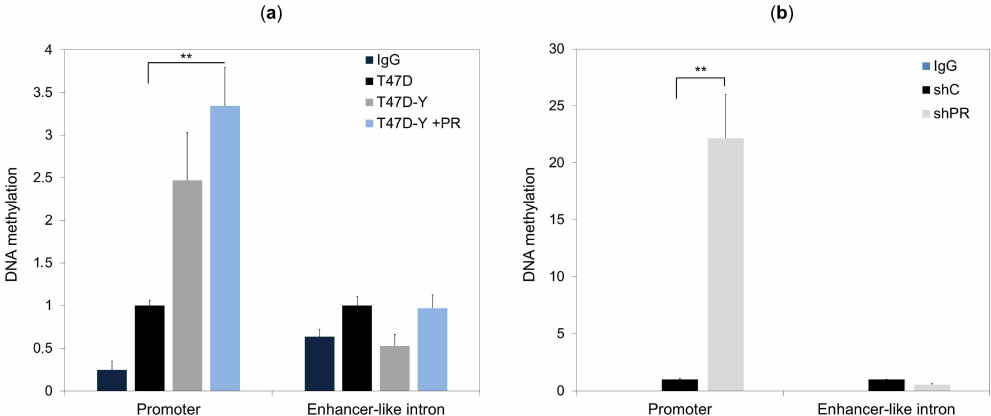
Figure 4. The loss of PR increases the DNA methylation level at the ESR1 promoter. DNA methylation of the ESR1 promoter and the enhancer-like intron was assessed by methylated DNA immunoprecipitation (MeDIP)-qPCR in T47D control cells, T47D-Y cells and T47D-Y cells with stable PR transfection (T47D-Y + PR) ( a ), or in T47D cells transduced with shRNA against PR (shPR; clone trcn0000010776) or IgG, negative control for immunoprecipitation. Error bars represent the SD of three